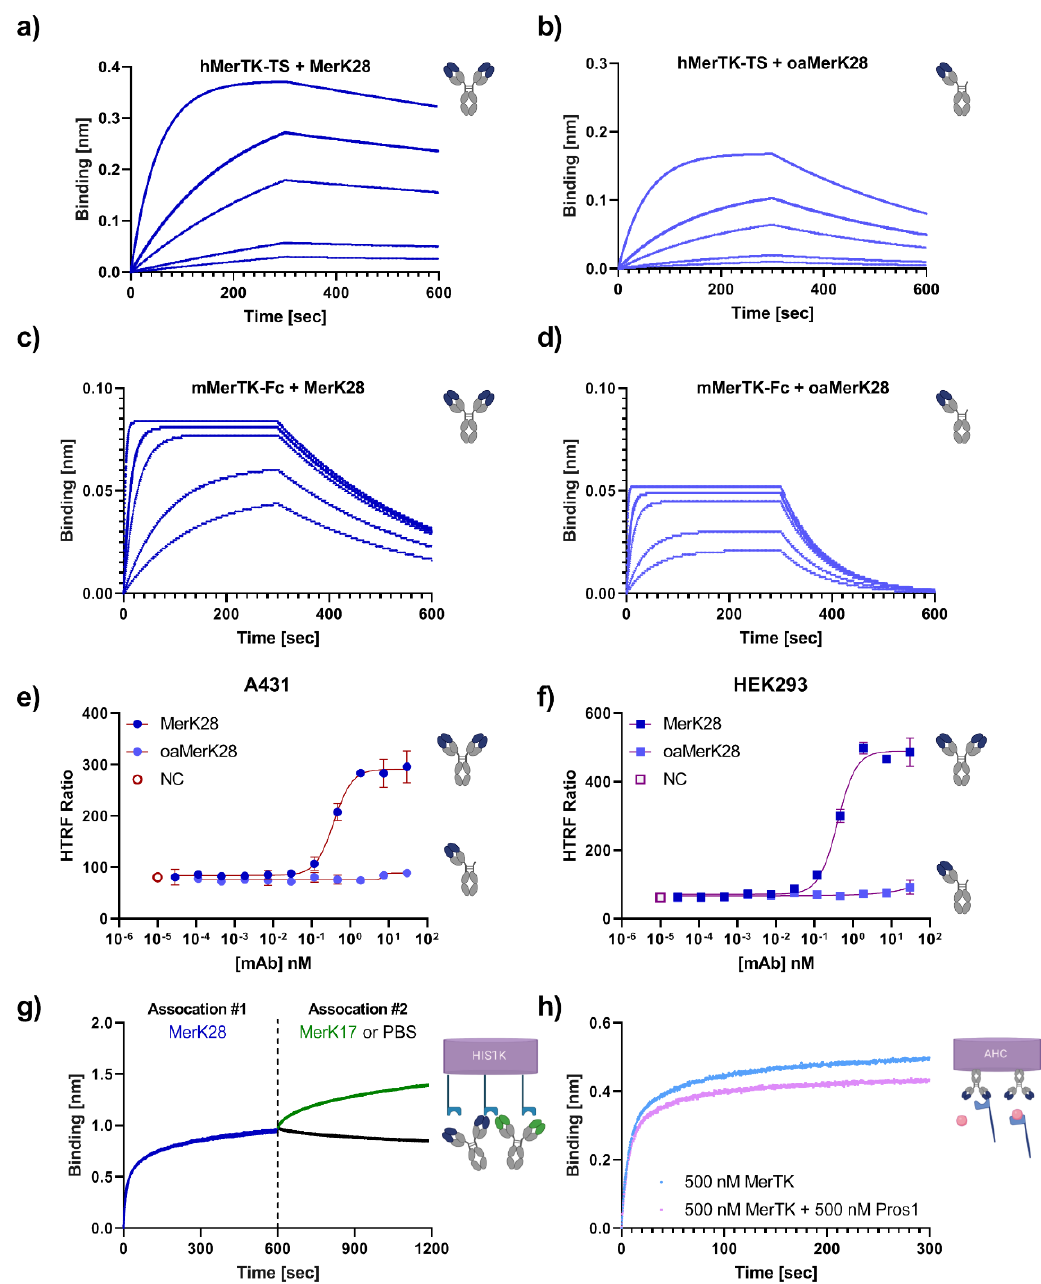
Figure 1. Characterisation of parental MerTK antibodies. Kinetics determination against soluble hMerTK-TS for either ( a ) MerK28 or ( b ) oaMerK28, and against mMerTK-Fc for ( c ) MerK28 or ( d ) oaMerK28. ( e , f ) Activation of signalling transduction with MerK28. pAKT HTRF assays with either A431 ( e ) or HEK293 ( f ) cells. Unstimulated cells are shown as “NC”, and the bivalent MerK28 and one-armed MerK28 (oaMerK28) are plotted. Error bars represent biological duplicate measure- ments. ( g ) Epitope binning of MerK28 (blue) and MerK17 (green) via BLI. Human MerTK-His 6 was immobilised on HIS1K biosensors and associated to the indicated antibodies for 600 s each. PBS is shown in black. ( h ) Ligand competition assay for MerK28. Association to hMerTK (light blue) alone or to MerTK pre-incubated with Pros1 ligand (pink).